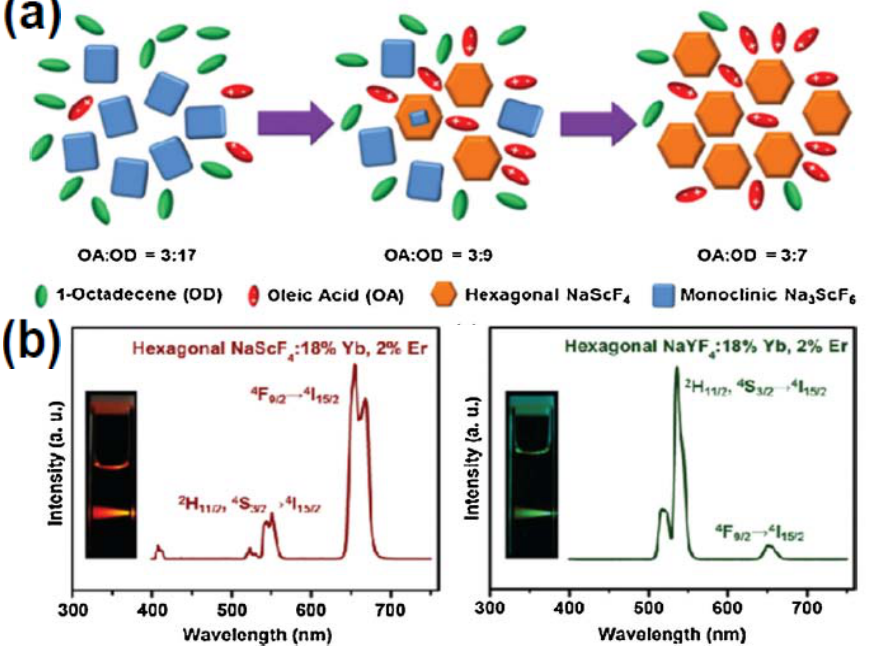
Figure 2. ( a ) Schematic illustration of the crystal structure evolution at varying polarities of the reaction medium. ( b ) Upconversion luminescence spectra of hexagonal-phase NaScF 4 :Yb/Er and NaYF 4 :Yb/Er nanocrystals. Reproduced from [35]. Copyright 2012, American Chemical